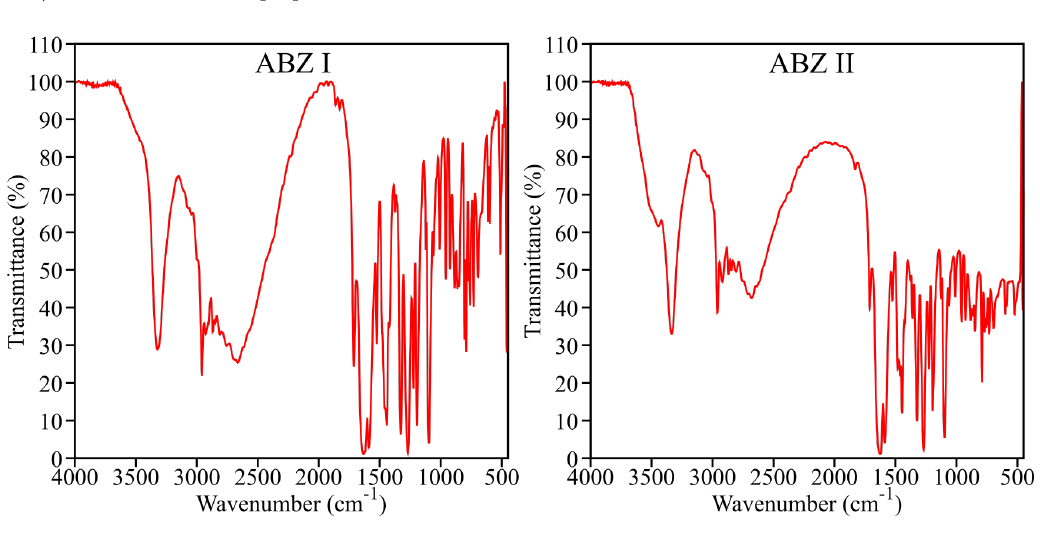
Figure 3. FT-IR spectrum of ABZ I and ABZ